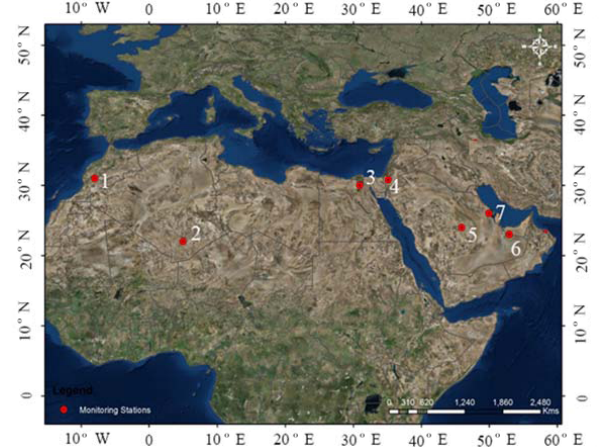
Figure 1. Location of the AERONET stations over North Africa and the Middle East. The numbers on the map indicate the site location as follows. 1: Saada, 2: Tamanrasset_INM, 3: Cairo, 4: Sde Boker, 5: Solar Village, 6: Mezaira, 7: